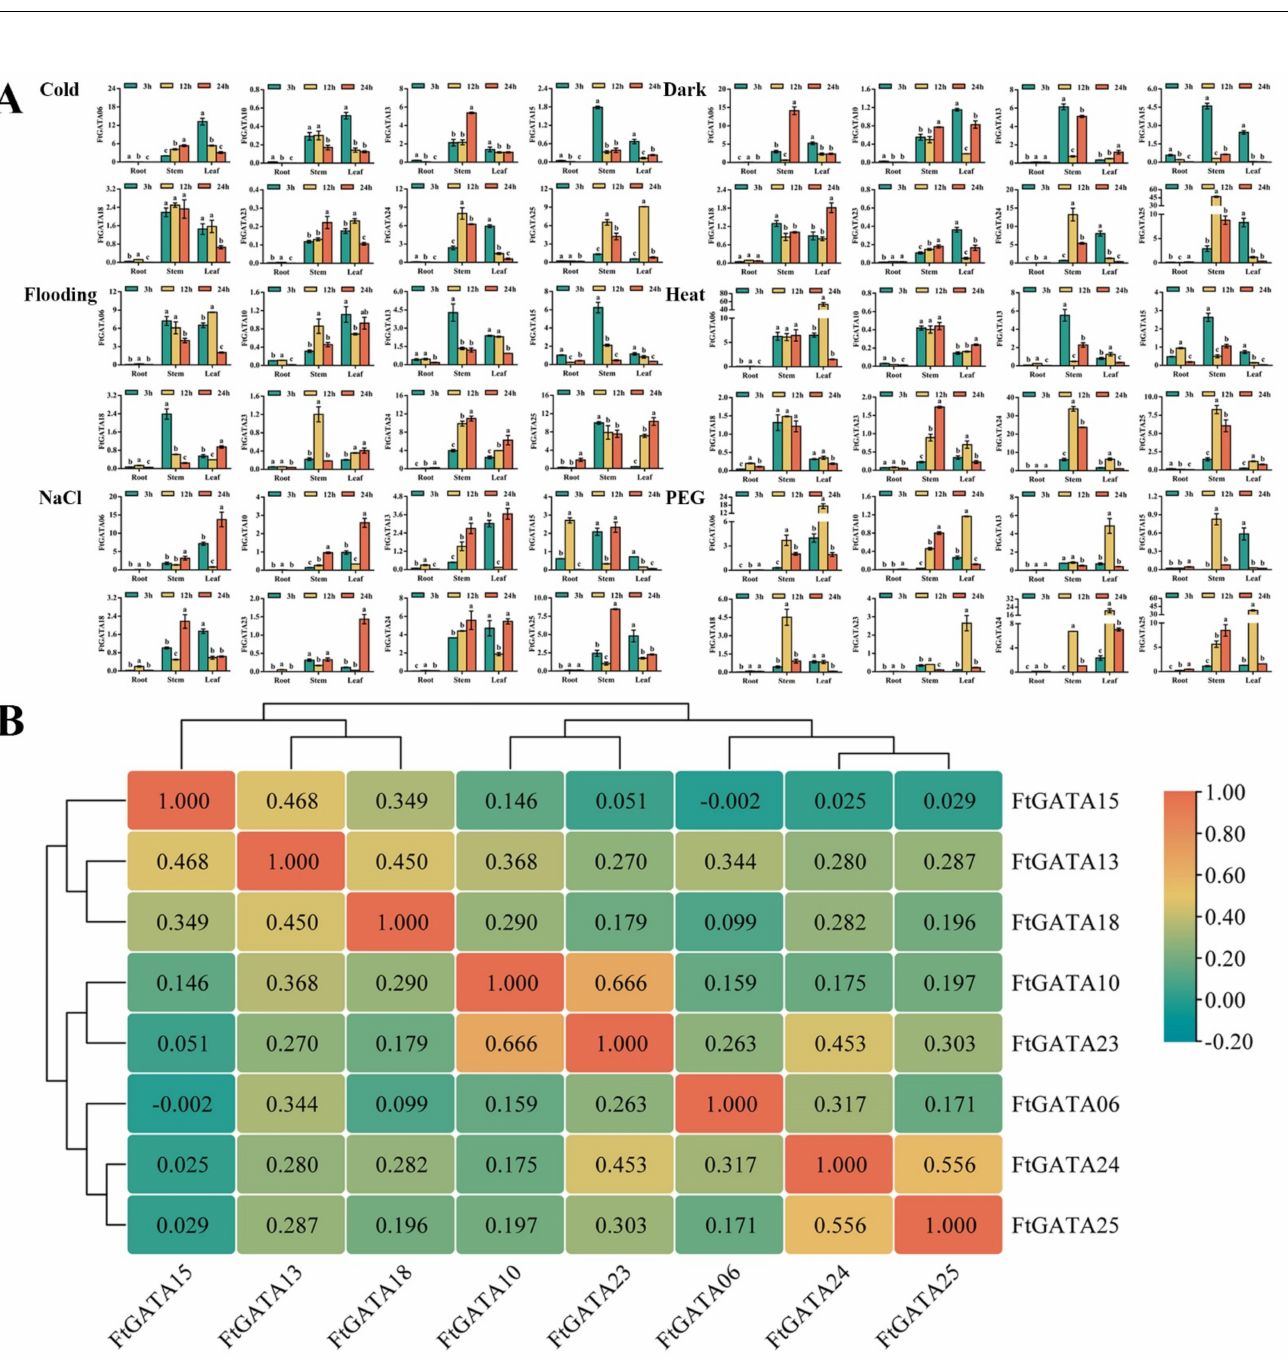
Figure 8. Spatiotemporal relative expression levels of eight Fagopyrum tataricum GATA genes ( Ft- GATA06 , FtGATA10 , FtGATA13 , FtGATA15 , FtGATA18 , FtGATA23 , FtGATA24 , and FtGATA25 ) under different stresses (cold, dark, flooding, heat, NaCl, and PEG) at the seedling stage and correlation hierarchical cluster analysis between their expression. ( A ) Expression patterns of eight GATA genes at 3 h, 12 h, and 24 h in roots, stems, and leaves. ( B ) Correlation analysis between their expression. Column chart values were expressed as the mean ± SD according to Duncan’s multiple comparisons; different lowercase letters represent significant differences among different treatments ( p <